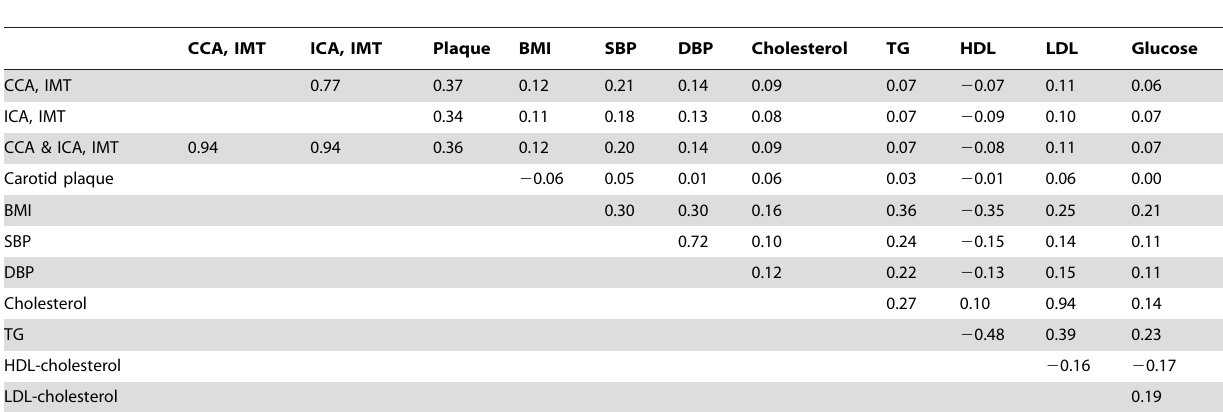
Table 2. Adjusted Spearman Correlation coefficients of carotid-artery intima-media thickness, plaque scores and various atherosclerotic risk